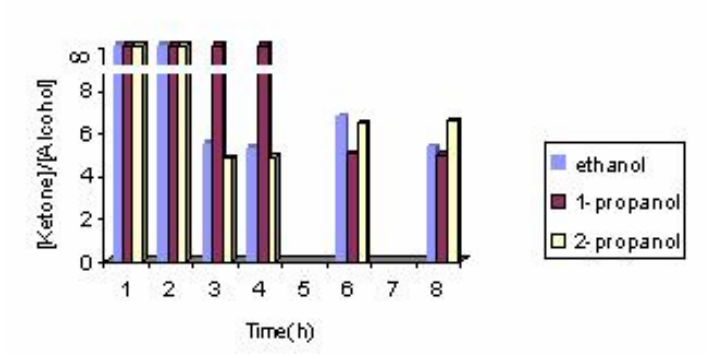
Figure 2 . Variation of the [acetophenone]/[1-phenylethanol] ratio vs. time for experiments 8, 9 and 10